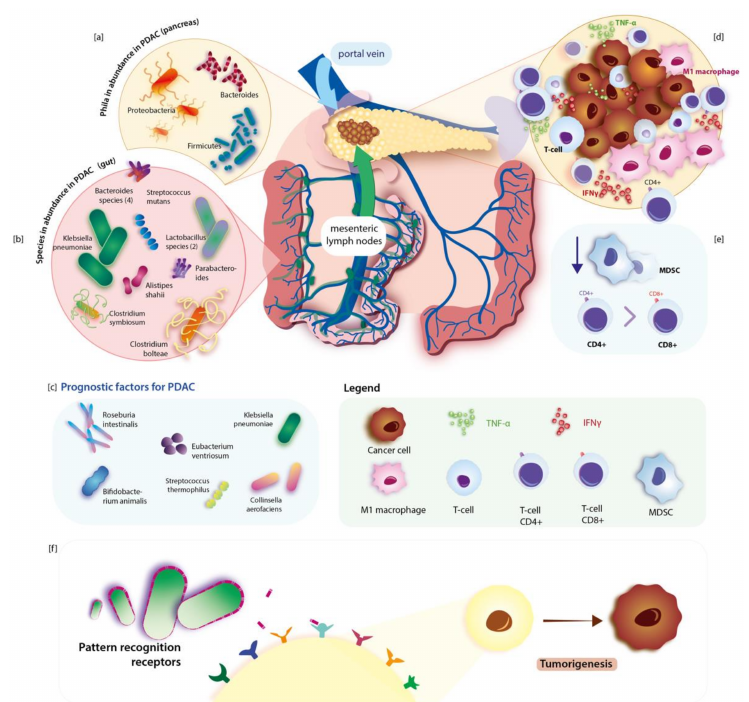
Figure 1. Dysbiotic alterations of the gut microbiome in pancreatic cancer regarding immunological response. Species of bacteria that are abundant in the gut in PDAC are listed in section ( b ). Some of them can be used as prognostic factors of PDAC and are found in section ( c ). Gut microbiota can migrate into the pancreas via a portal vein or mesenteric lymph flow. Phyla that are abundant in the pancreas during PDAC are illustrated in section ( a ). Sections ( d ) and ( e ) illustrate peri-tumoral immunological response in PDAC: the increase of intra-tumoral T-cells, pro-inflammatory M1-like tutor associated macrophages, CD4, levels of pro-inflammatory cytokines (such as TNF- α , IFN γ ) and reduction of MDCS. Pathogens can stimulate tumorigenesis by activating inflammation-inducing PRRs. The mechanism of pathogenesis of PDAC is illustrated in section ( f ). Own elaboration based on